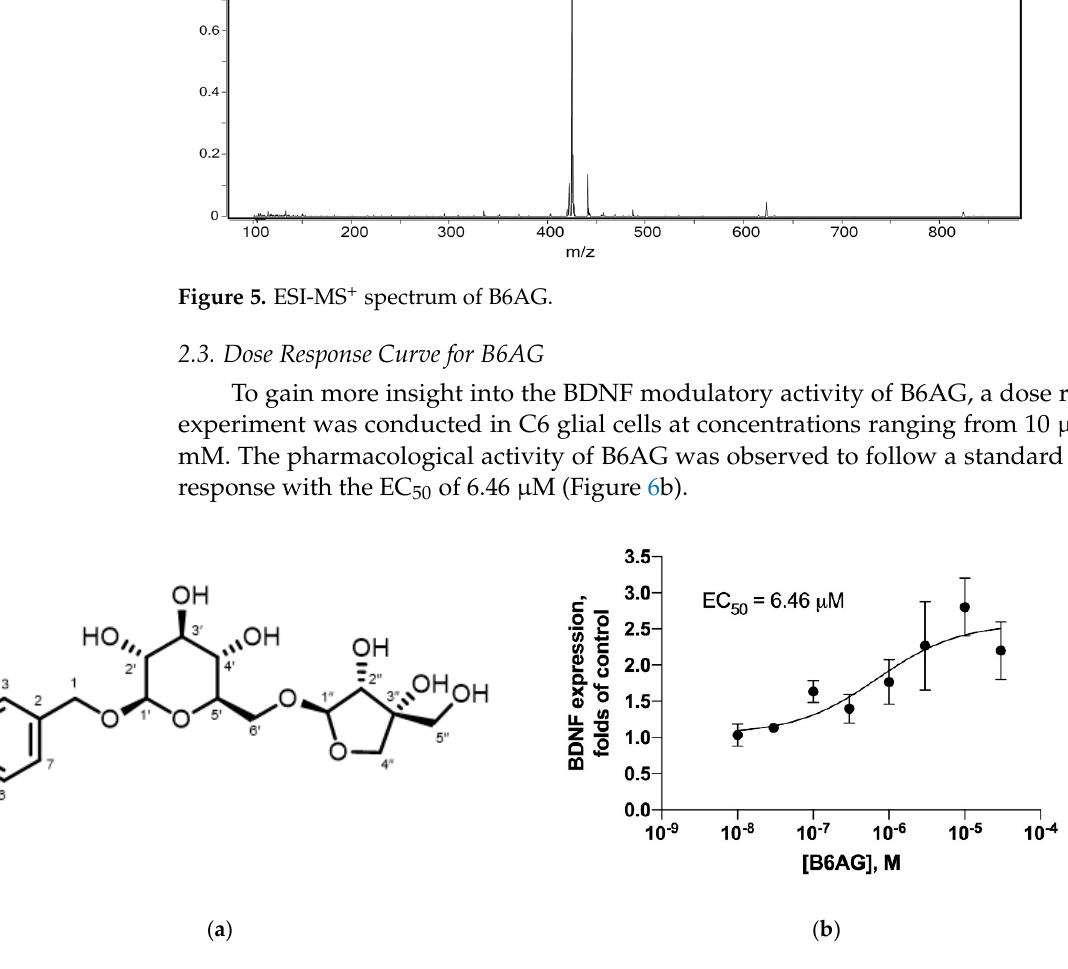
Figure 6. Benzyl 6-O- β -D-apiofuranosyl- β -D-glucoside (B6AG) isolated from sage leaves with BDNF stimulatory activity. ( a ) Chemical structure of B6AG. ( b ) Dose response curve for B6AG upregulation of BDNF mRNA expression.